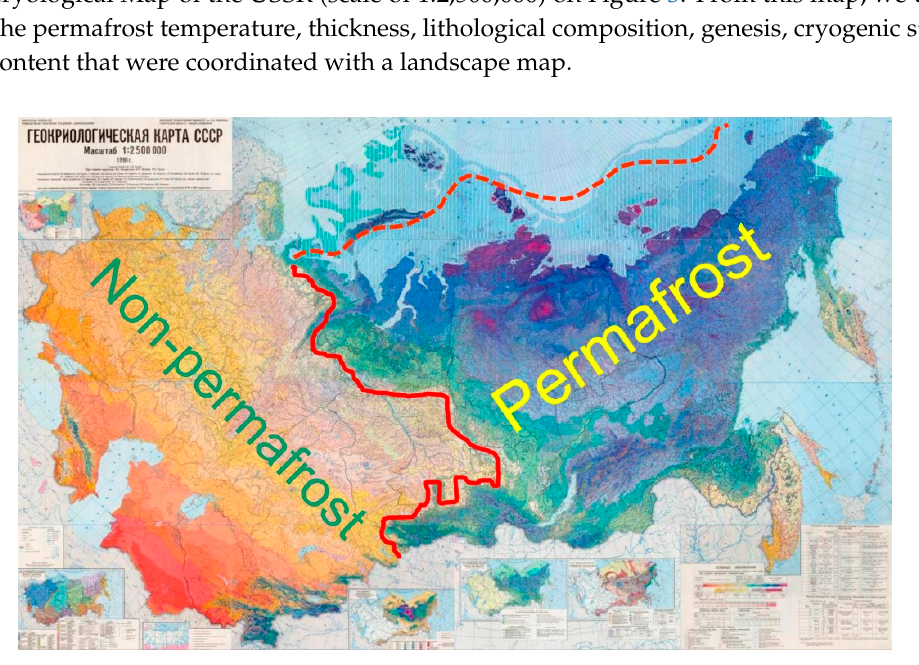
Figure 3. The Geocryological Map of the USSR, scale 1:2,500,000.